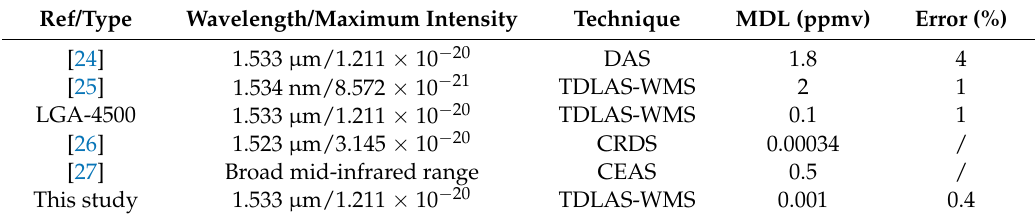
Table 1. Performance comparison of the proposed C 2 H 2 sensor and the reported C 2 H 2